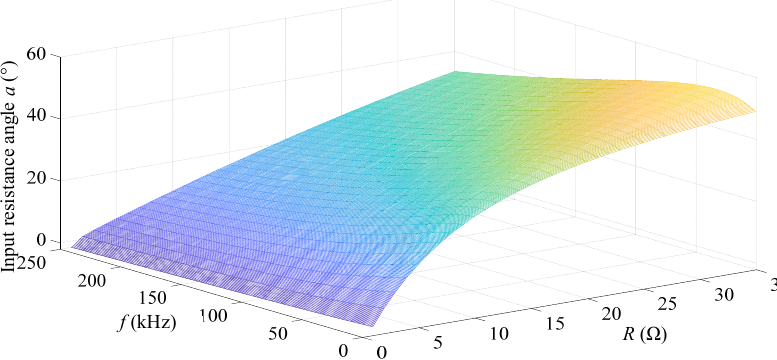
Figure 12. The relationship between input impedance angle α and system frequency f , load R .